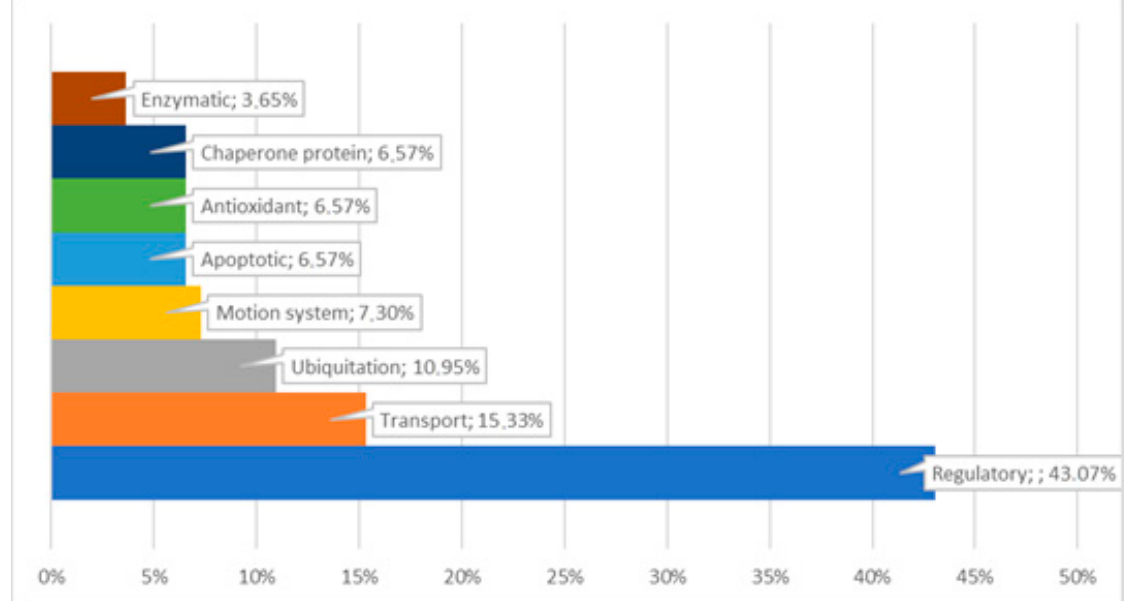
Figure 4. SDS-PAGE profile of phosphoproteins obtained during the breeding season ( A ) and out of the breeding season ( B ). A total of 27 arrows present proteins identified by nanoLC–MS/MS spectrometry. C1—caput, C2—corpus, C3—cauda. Std.—molecular weight standards.